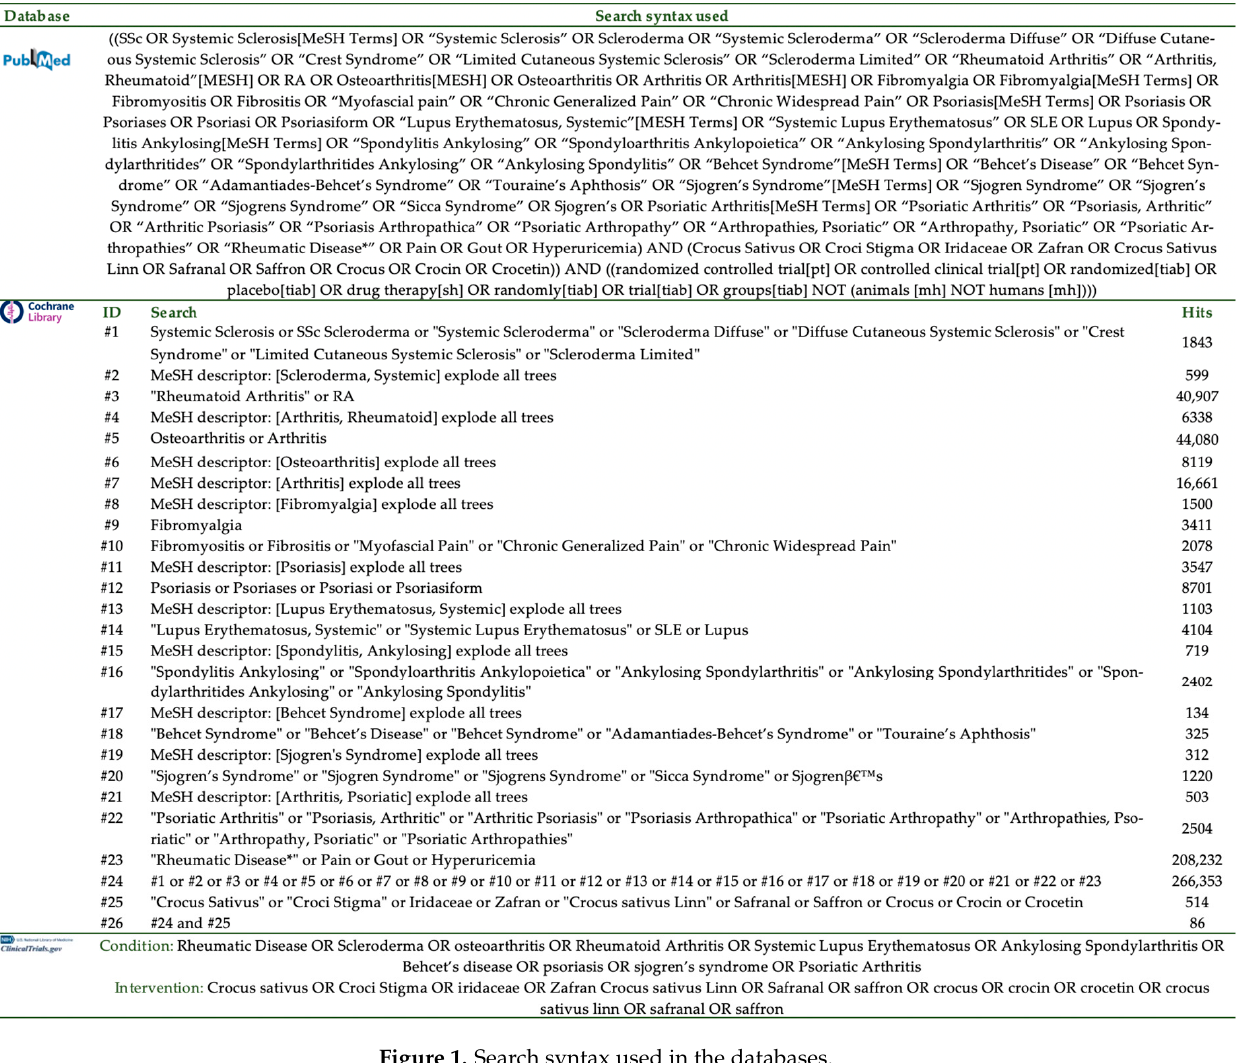
Figure 1. Search syntax used in the databases.